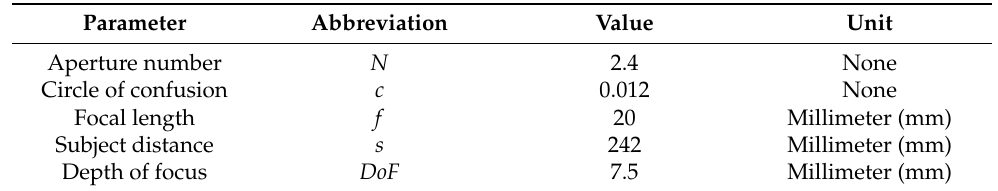
Table 2. The design of the depth of focus in the AOI.